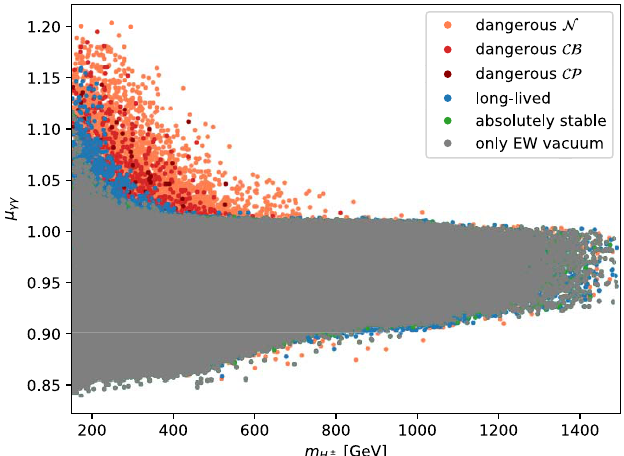
Figure 2 . The difference in the value of the scalar potential between the EW a secondary minimum according to eq. (2.55) as a function of tan β at the EW vacuum. Only N parameter points where a secondary vacuum exists are shown. The color code is based on the N results of the numerical analysis. The green parameter points have a secondary tunnelling from the EW vacuum is not possible. For the blue parameter points tunnelling is possible but slow (see eq. (3.8)) while the EW vacuum in the red points (plotted on top) is short-lived for tunnelling to the minimum. N